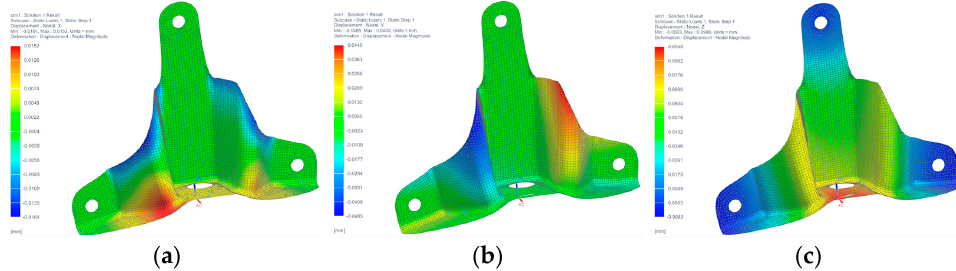
Figure 16. FEM results from deformation according: ( a ) xx ( b ) yy ( c ) zz . (dimensions are in mm).